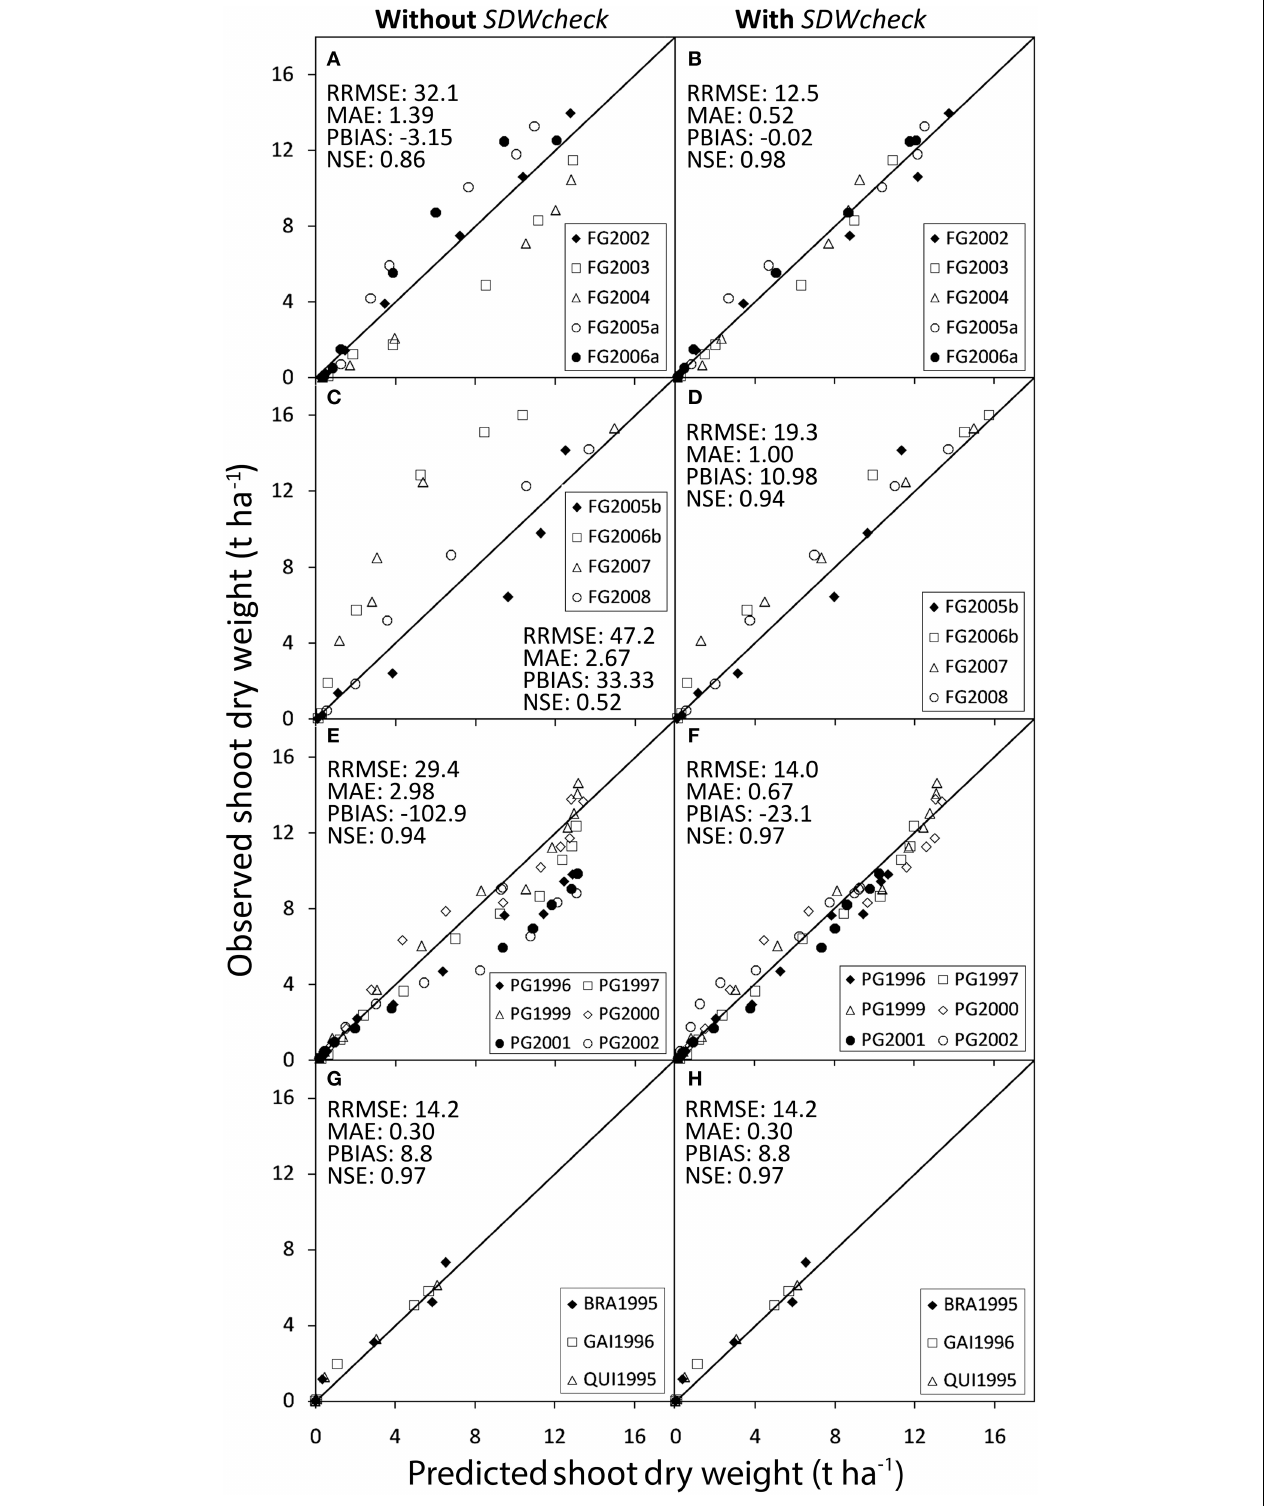
FIGURE 2 | Observed values of shoot dry weight against values predicted by GesCoN in the trials used for calibrating (A,B: Foggia calibration trials) and validating the software (C,D: Foggia validation trials; E,F: Perugia trials; G,H: Florida trials). For each